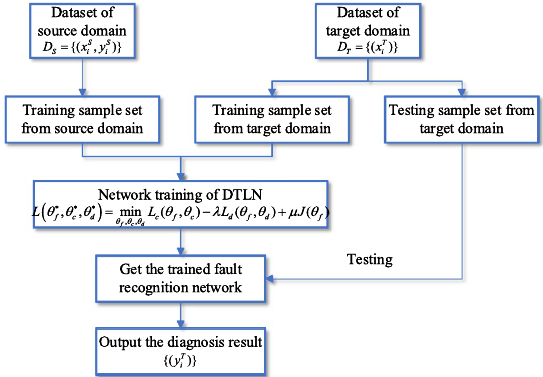
Fig. 3 Flowchart of the proposed